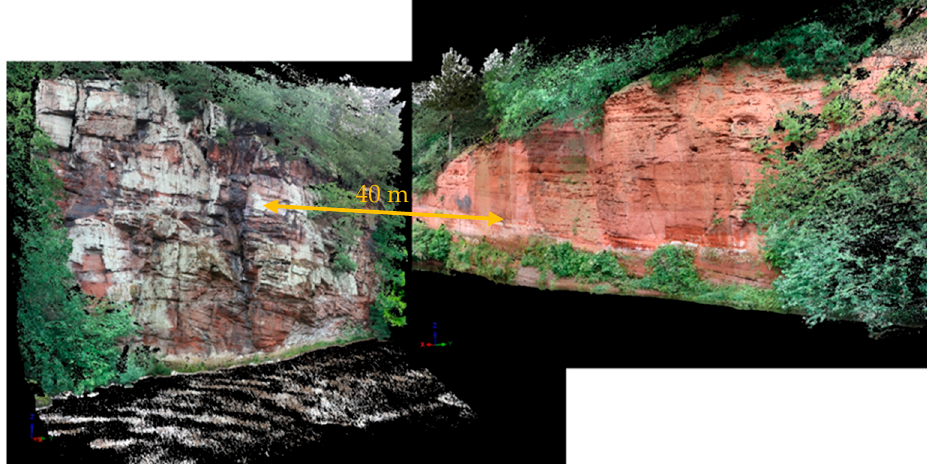
Figure 20. Virtual outcrop models of Eden Valley outcrop.